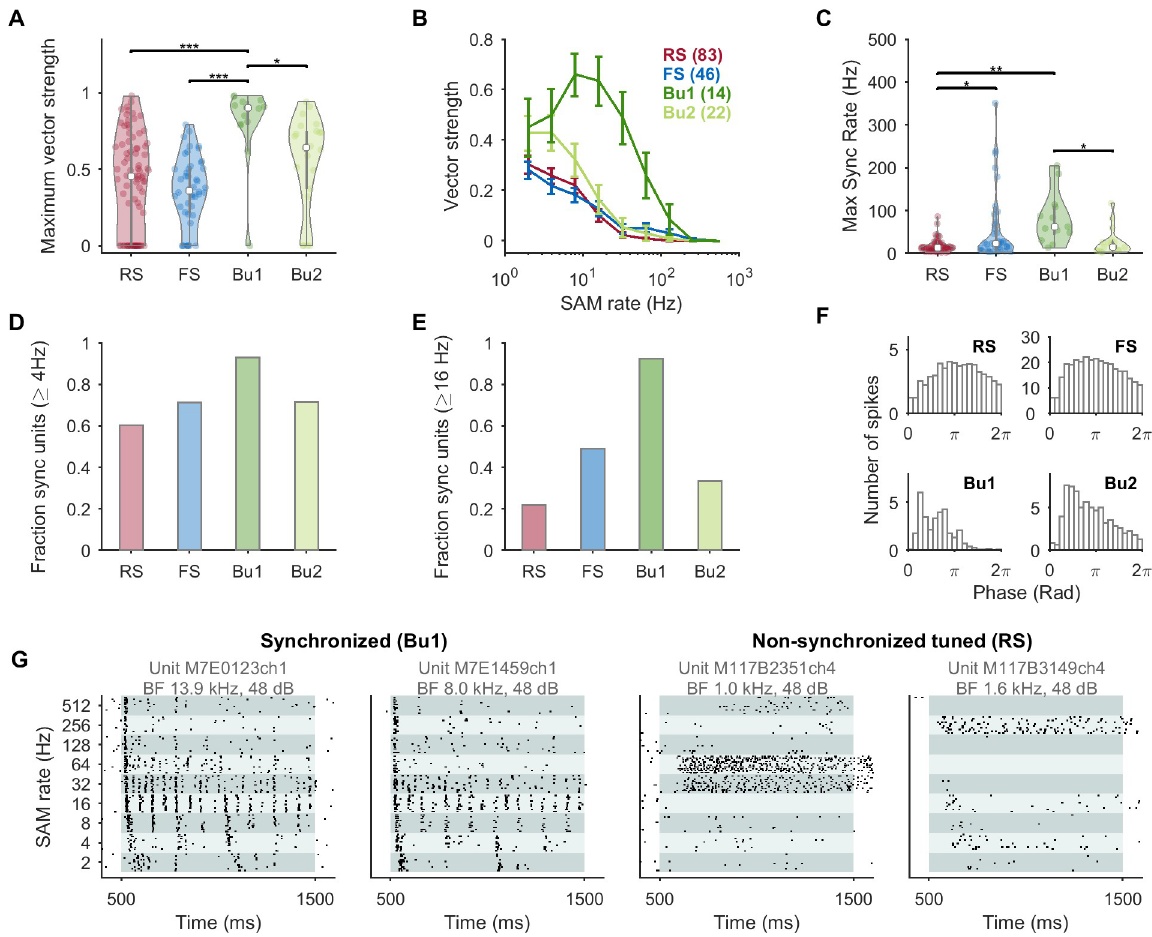
Fig 5. In response to sinusoidally amplitude modulated sounds, bursting neurons had higher VS, were more likely to be synchronized and up to higher rates, and responded in the early phase of the cycle. (A) Violin plot of maximum VS. Nonsignificant VS values were set to 0 (see Materials and methods). Bursting types had high VS values. For (A) and (C), Welch’s ANOVA was statistically significant ( F 3,42.0 = 11.3, p < 0.0005) and significant pairs from post hoc testing are indicated. (B) Mean VS versus modulation rate. Bu1 units show bandpass behavior; Bu2 also has elevated VS. (C) The maximum modulation rate with a significant VS was much higher for the Bu1 population, although some FS- like units were also able to phase-lock to high modulation rates. Units were considered to be synchronized if they had a significant Rayleigh statistic at or above 4 Hz (D) or 16 Hz (E) and a VS of at least 0.1; units with no significant temporal or rate response in the modulation range considered were excluded. A majority of Bu1 units were synchronized. (F) Average period histograms for stimulation at 2 Hz. (G) Examples of 2 highly synchronized units labeled Bu1 by criteria and Bu by the GMM (left) and 2 nonsynchronized units that were tuned to SAM rate that were labeled RS (right). Data underlying this figure can be found in S1 Data. Bu, bursting; FS, fast-spiking; GMM, Gaussian mixture model; RS, regular-spiking; SAM, sinusoidal amplitude modulation; VS, vector